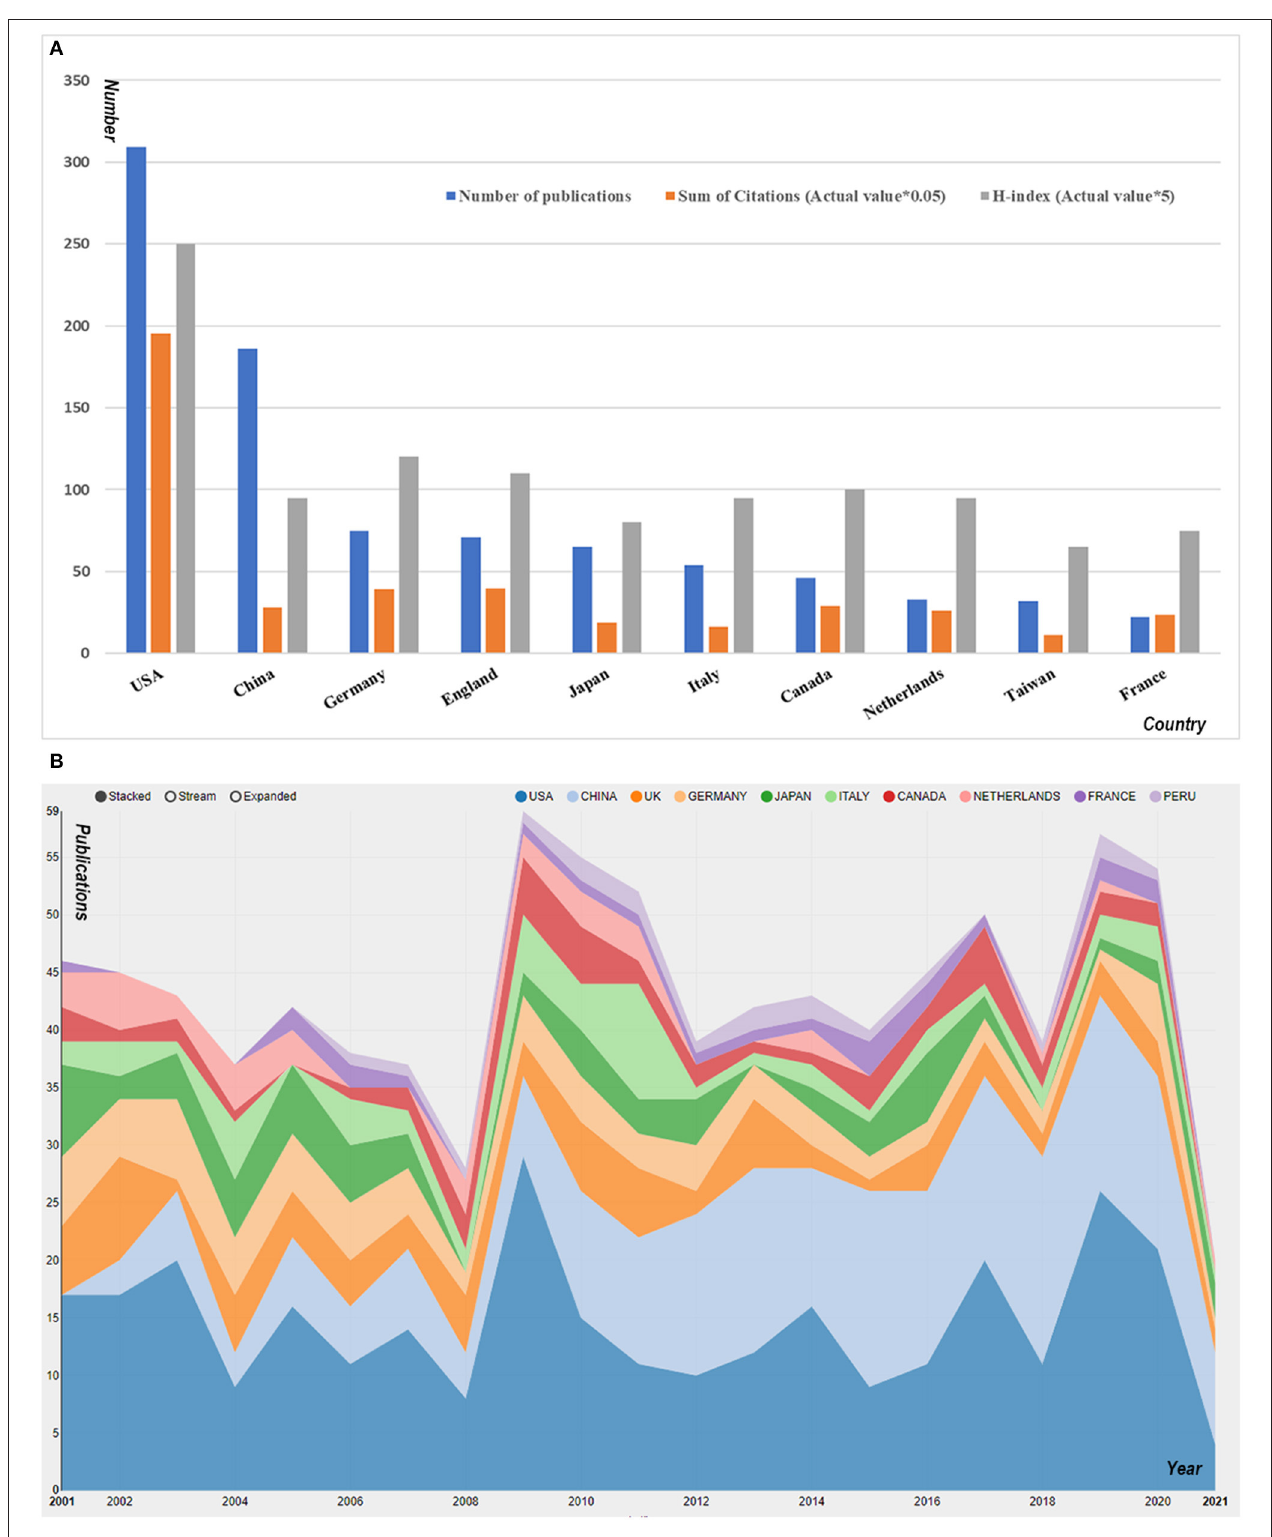
FIGURE 4 | The contributions of different countries/regions to the research field concerning MODS. (A) The number of publications, citation frequency ( × 0.05), and H-index ( × 5) in the top 10 countries or regions. (B) The growth trends of the top 10 countries/regions in MODS from 2001 to 2021.